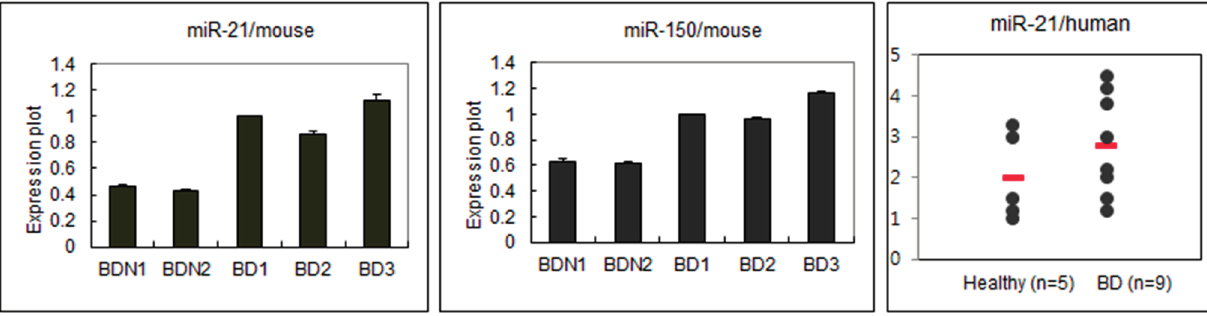
Figure 1. Expressions of miR-21 and miR-150 in BD mice and miR-21 in BD patients. In mice, the expression of miR-21 and miR-150 was higher in BD than BDN. In human, miR-21 was also higher in BD patients than healthy control.